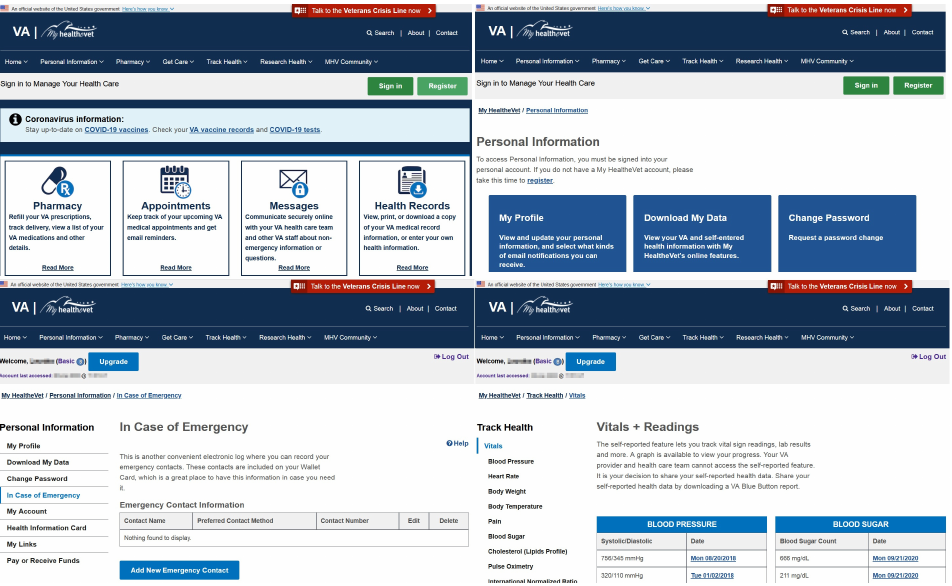
Figure 8. HealthVet screen